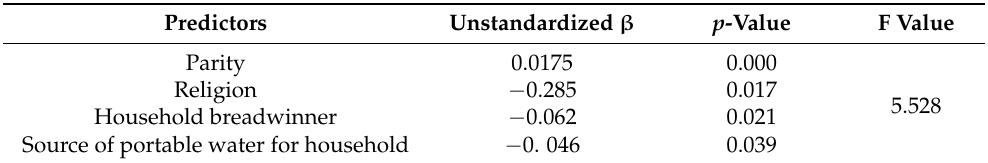
Table 7. Regression coefficient of the socioeconomic status of the household as predictors of adequacy of minimum dietary diversity of the preschool